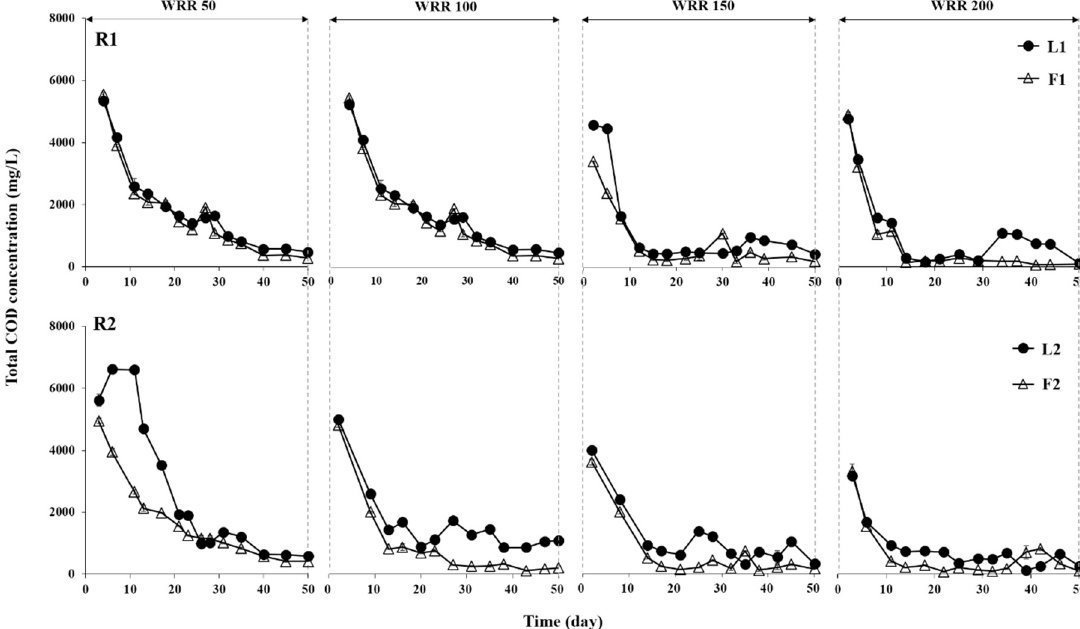
Figure 2. Total COD profiles of the LBR and AF in R1 and R2 during the batch experiment at each WRR (mL/d).